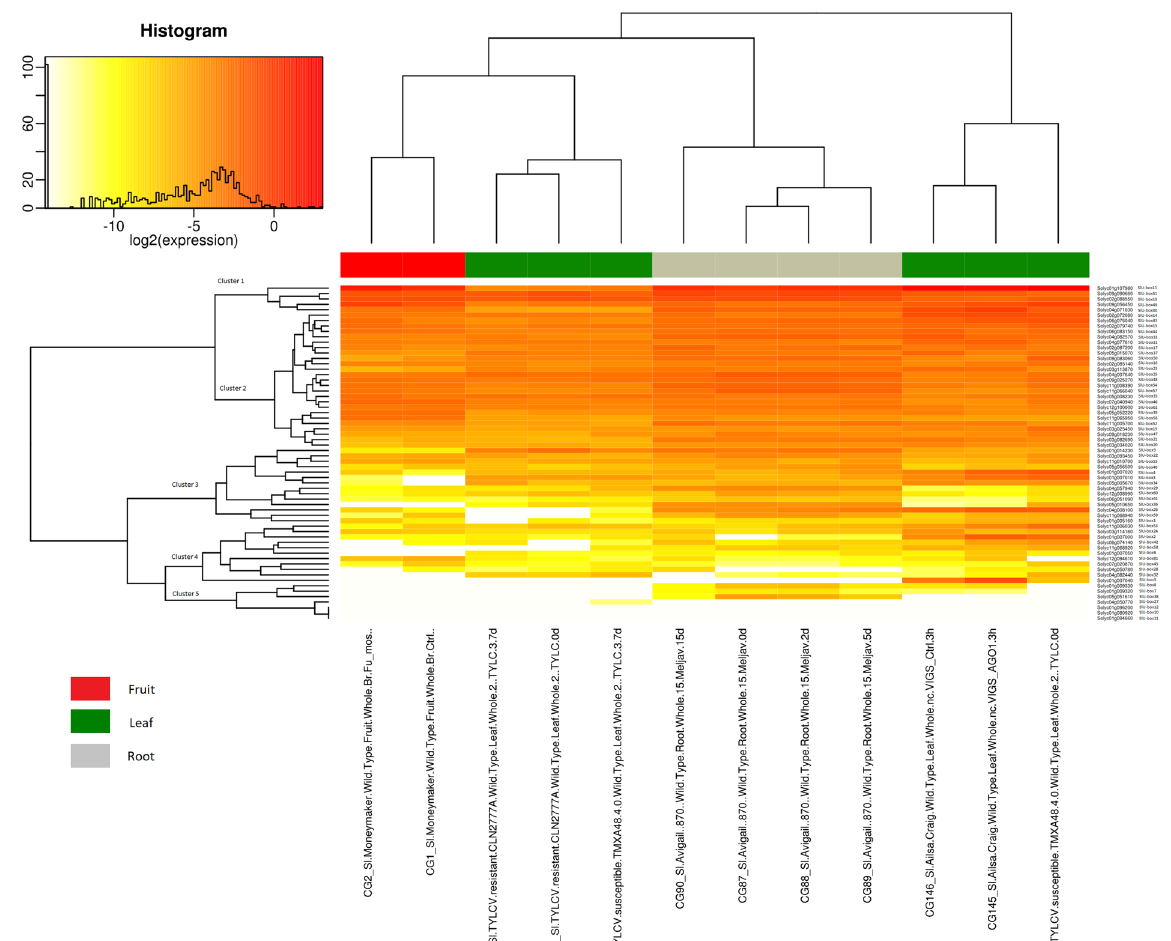
Figure 7. The gene expression level of the 62 U-box gene family members under biotic stress treated tissues is represented by a heat map. (For detailed conditions refer Supplementary Table